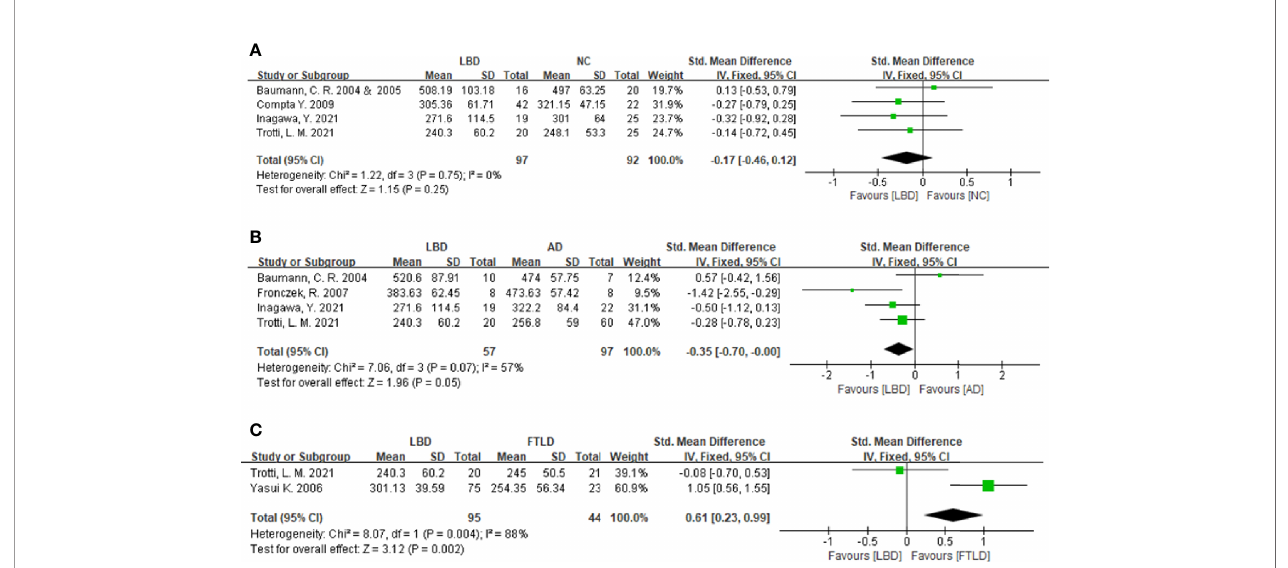
FIGURE 2 | Forest plots of the CSF orexin-A levels in LBD compared with NCs/other diseases. (A) Forest plot of CSF orexin-A levels in LBD compared with NCs. (B) Forest plot of CSF orexin-A levels in LBD compared with AD. (C) Forest plot of CSF orexin-A levels in LBD compared with FTLD. CI, con fi dence interval; CSF, cerebrospinal fl uid; LBD, Lewy body disease; NC, normal controls; AD, Alzheimer ’ s disease; FTLD, frontotemporal lobar